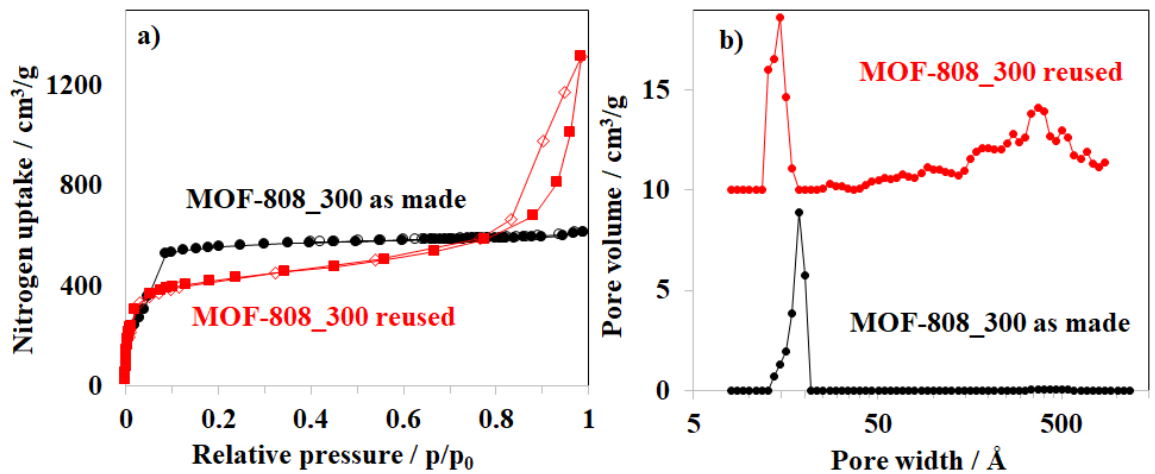
Figure 15. ( a ) Nitrogen physisorption isotherms and ( b ) pore size distribution of as made MOF-808 and MOF-808 after the fourth use.